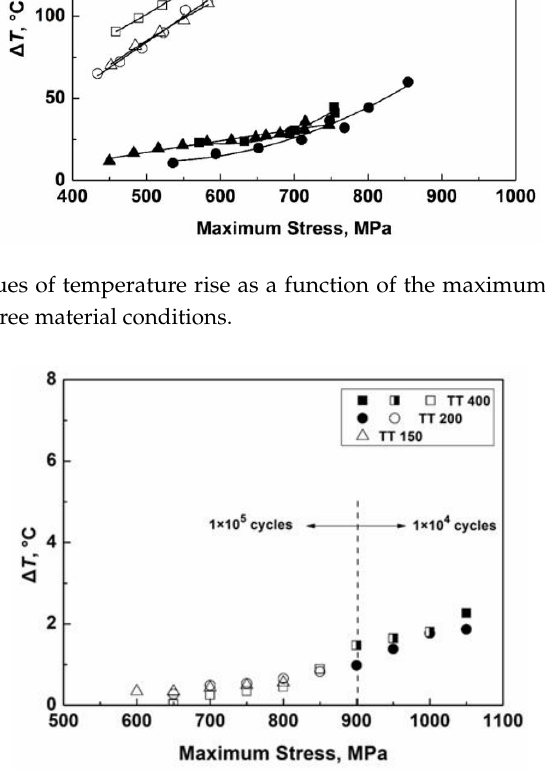
Figure 7. Average values of temperature rise as a function of the maximum stress by the EA method for three material conditions.